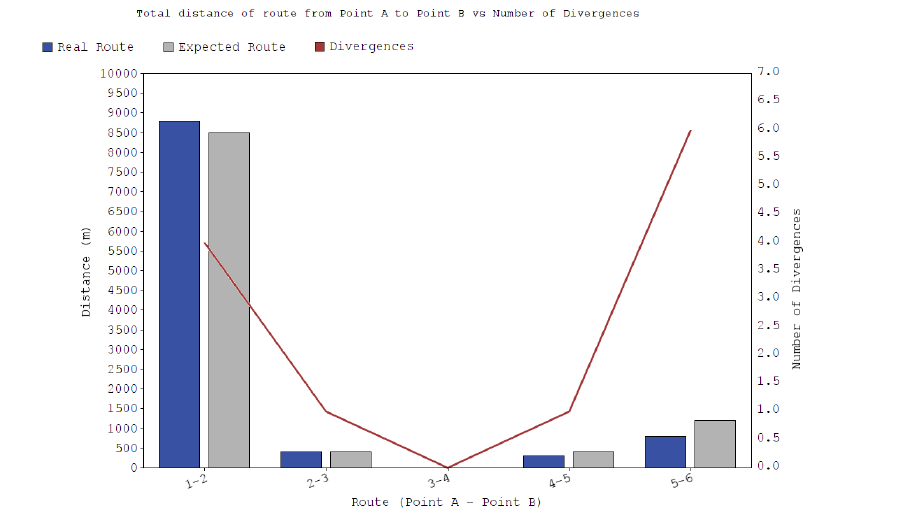
Figure 7. Graph of relation between total divergences, real route distance, and suggested route